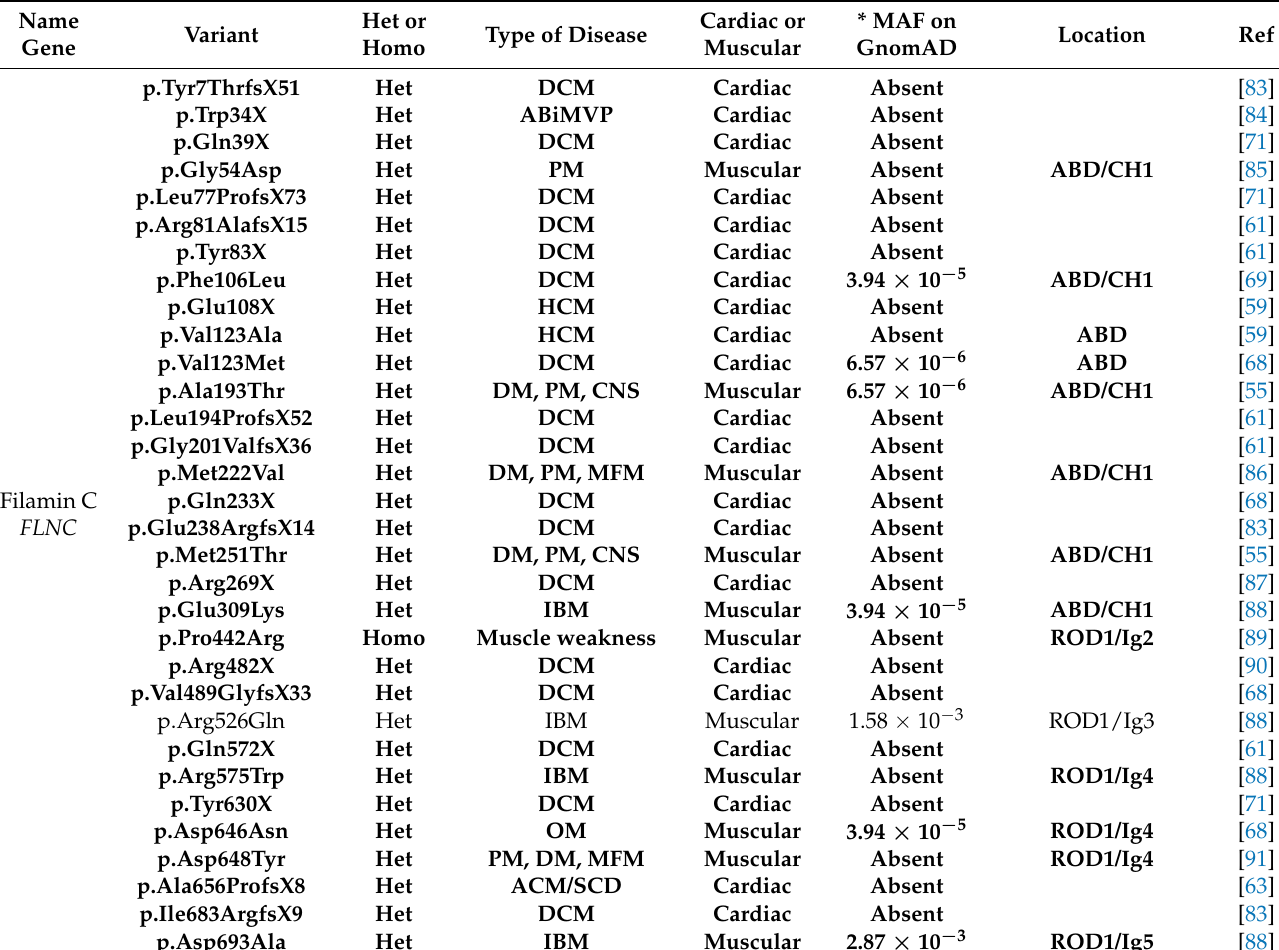
Table 2. Variants in the FLNC gene that have been previously reported in individuals with myopathy or cardiomyopathy. Name